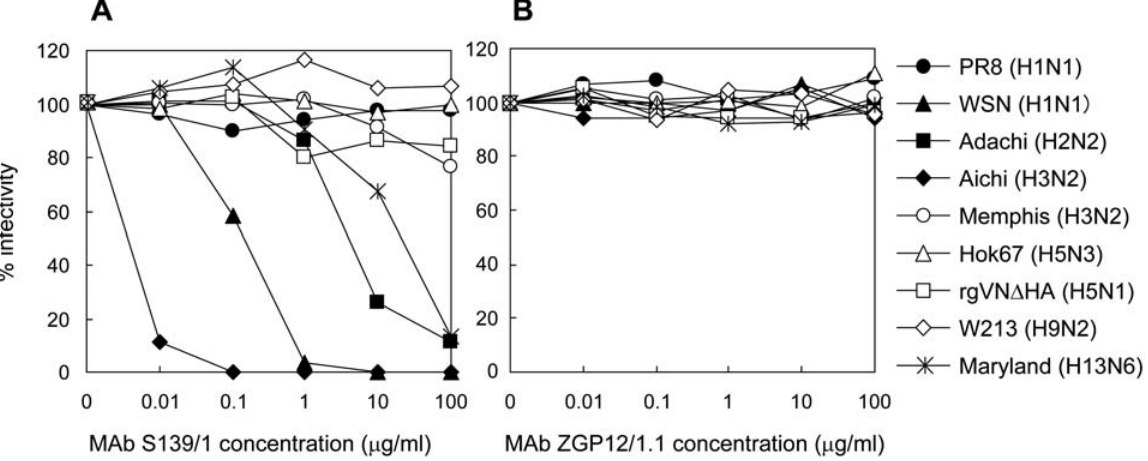
Figure 2. Neutralization activity of MAb S139/1 to various HA subtypes of influenza A virus strains. Viruses were mixed with indicated concentrations of the purified MAb S139/1 (A) or control IgG2a (ZGP12/1.1) [18] (B). Neutralization activities were evaluated by plaque reduction assays using MDCK cells.